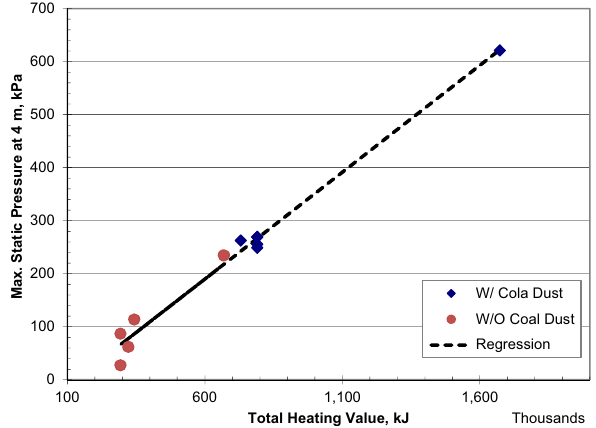
Fig. 5 Total heating value versus maximum explosion pressure (reanalyzed NIOSH test